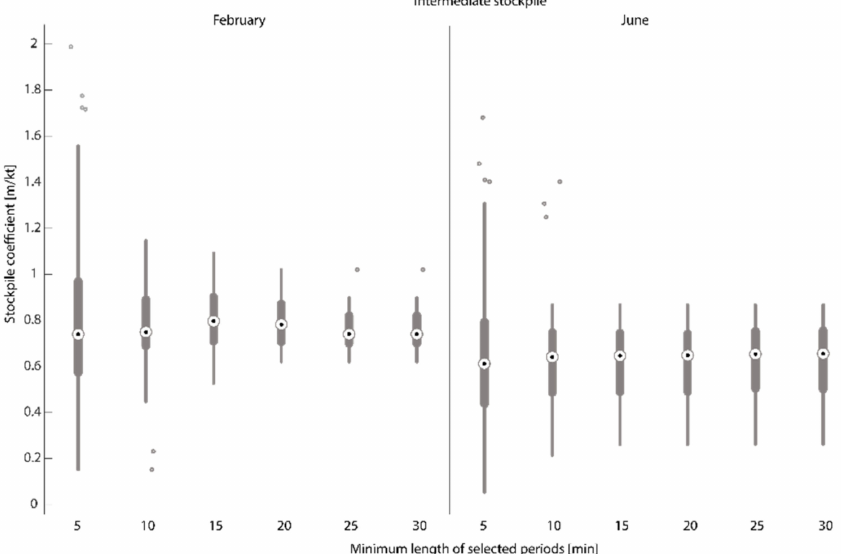
Figure 8. Box plot of the coefficients for different minimum durations in February and June for the intermediate